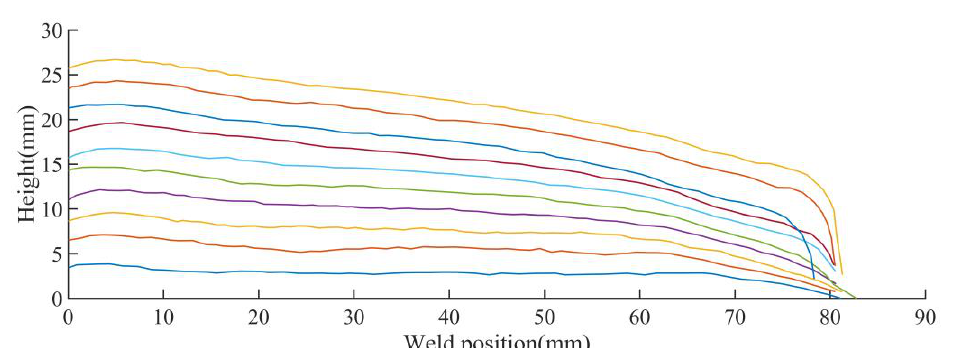
Figure 2. Workpiece formed by additive manufacturing.